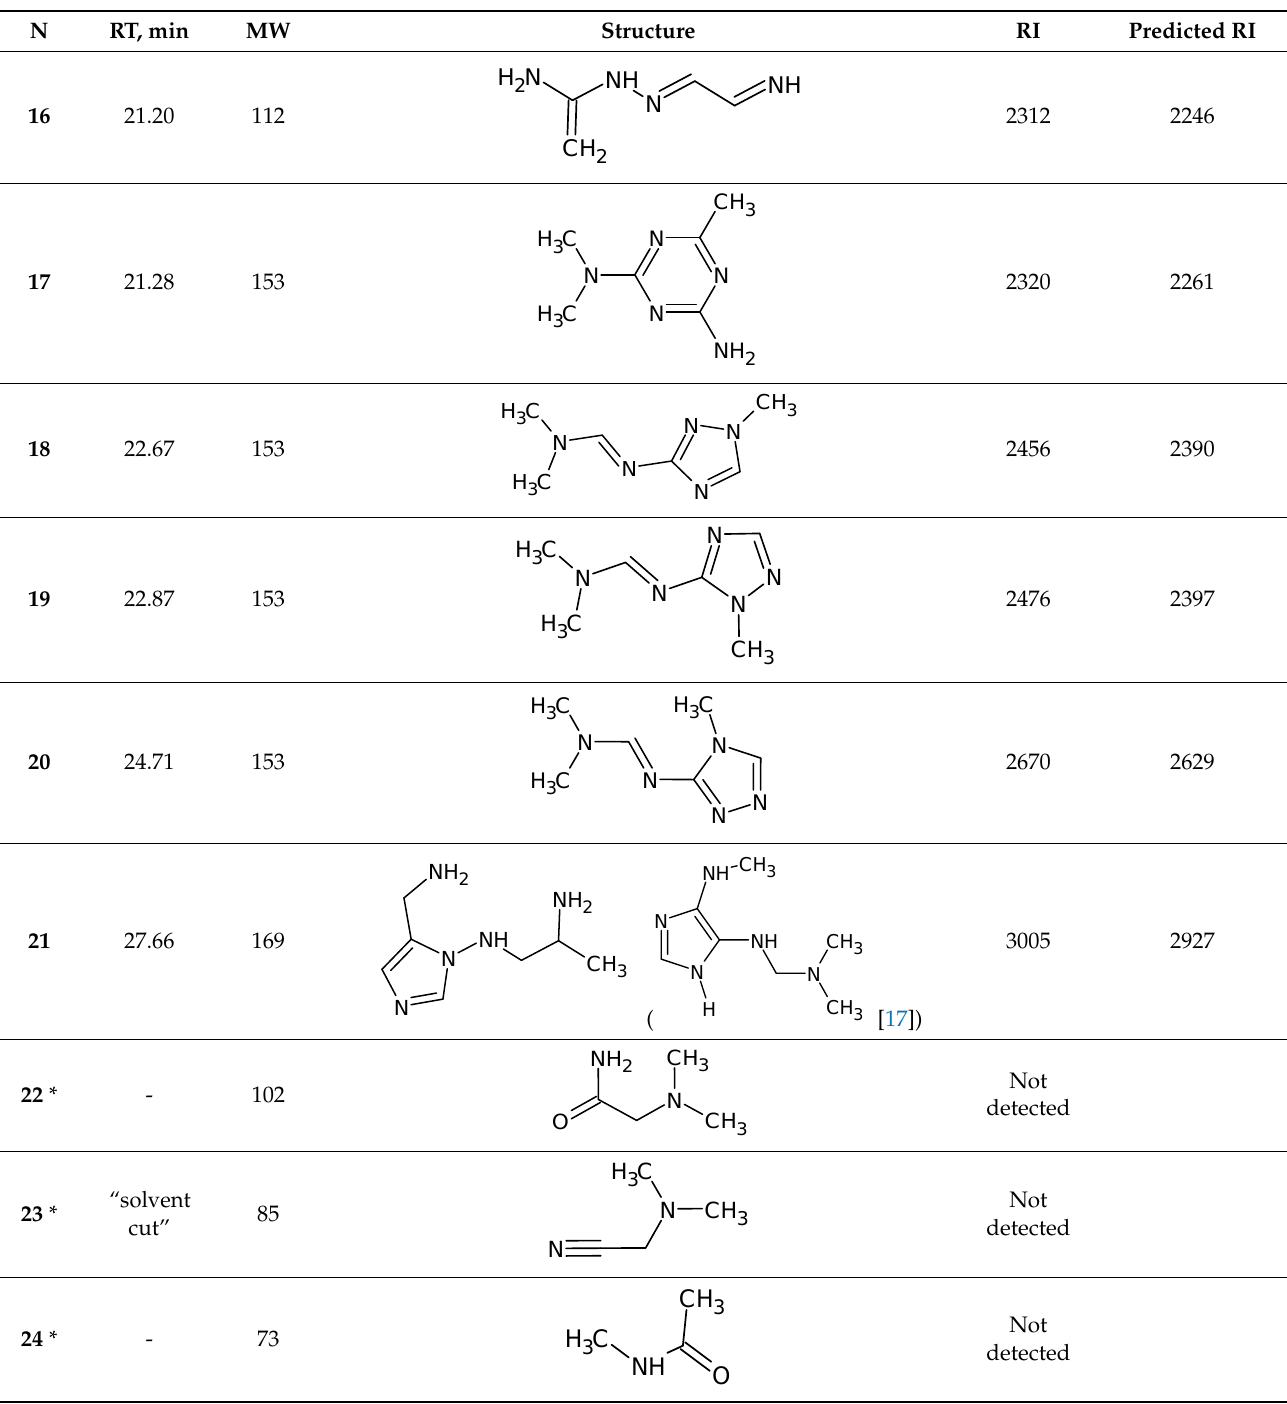
Table 3. Proposed structures of detected unsymmetrical dimethylhydrazine transformation prod- ucts. Retention time (RT) and retention index (RI) for the polar stationary phase, and RI for the non- polar stationary phase are given. The EPA acute toxicity category is also given.